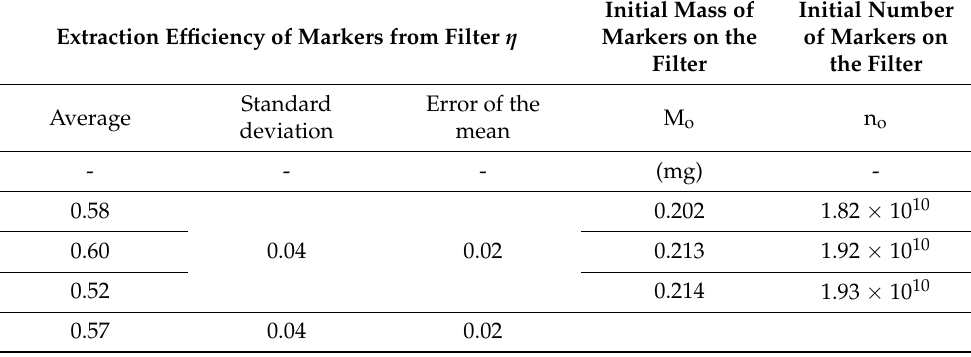
Markers on the of Markers on